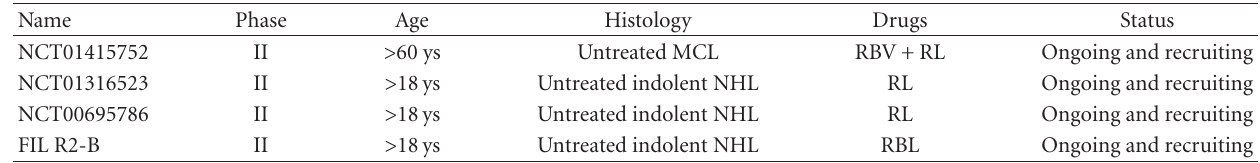
Table 6: Ongoing lenalidomide-based regime trials.